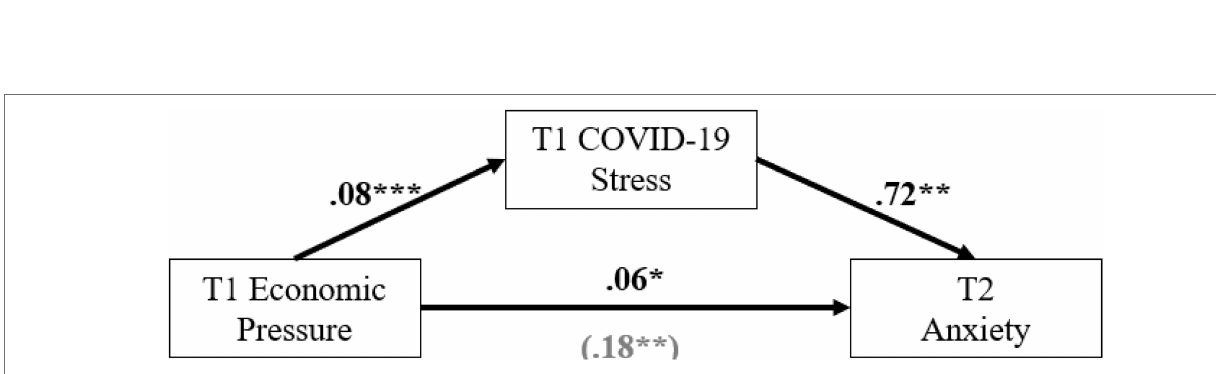
FIGURE 1 | COVID-19 stress as a mediator between economic pressure and later depression. * p < 0.05; ** p < 0.01; *** p < 0.001.